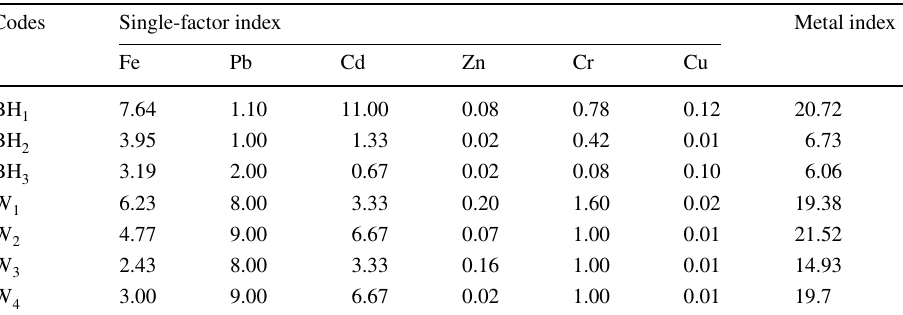
Table 11 Single-factor and a metal index of underground water samples collected from the Oti Community